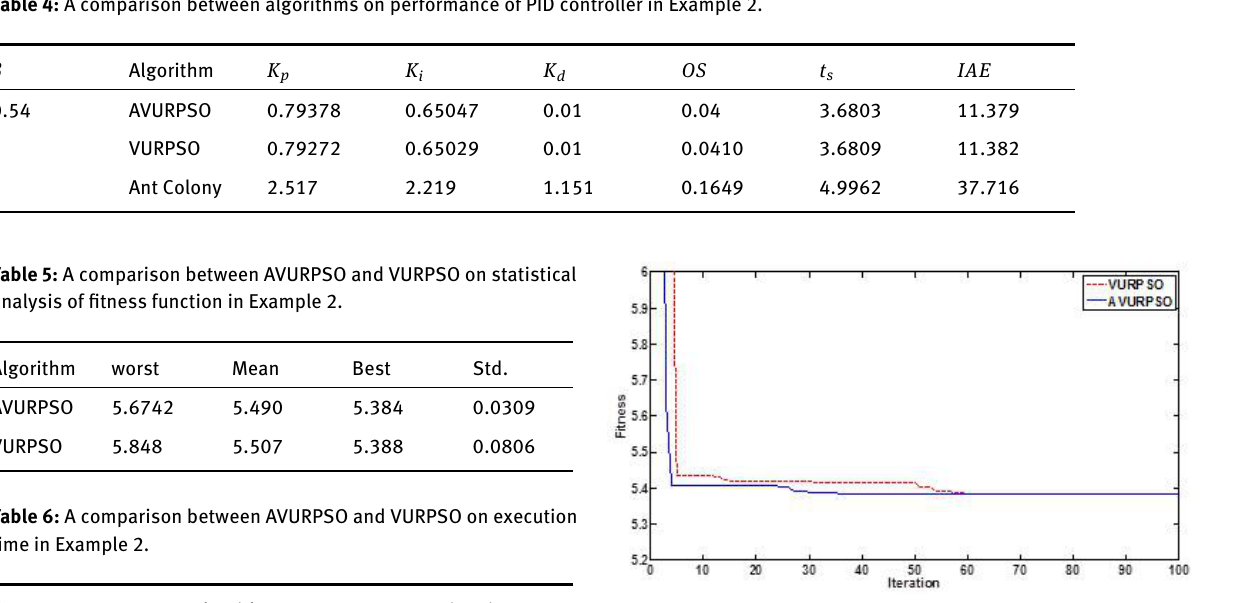
Table 4: A comparison between algorithms on performance of PID controller in Example 2.